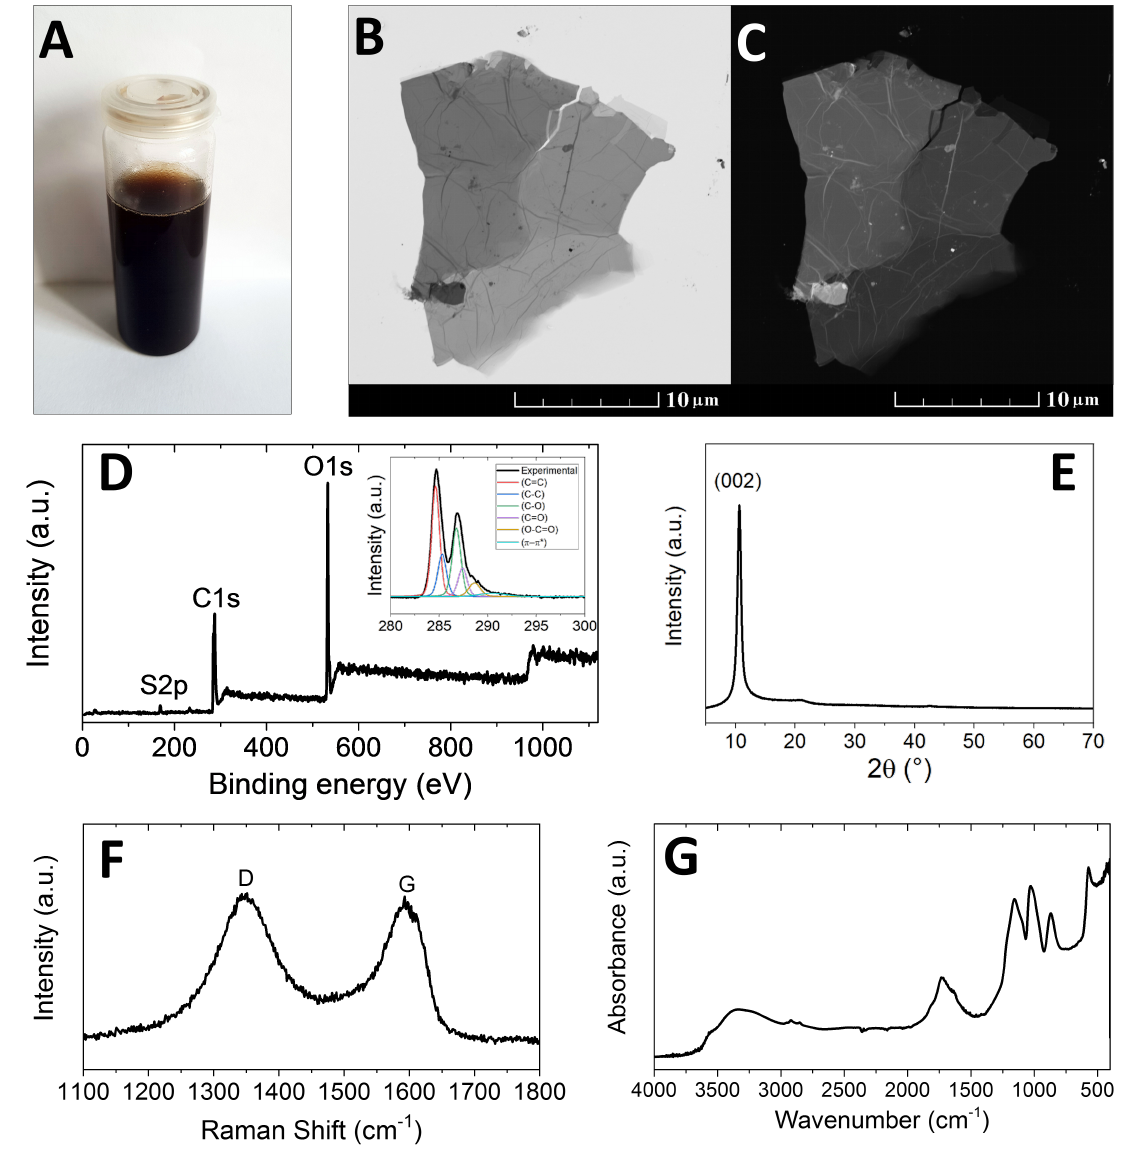
Figure 1. ( A ) GO suspension, ( B ) STEM image of GO in bright field mode, ( C ) STEM image of GO in dark field mode, ( D ) XPS survey spectrum and C1s detail, ( E ) XRD analysis of GO, ( F ) Raman spectroscopy of GO and ( G ) FT-IR analysis of